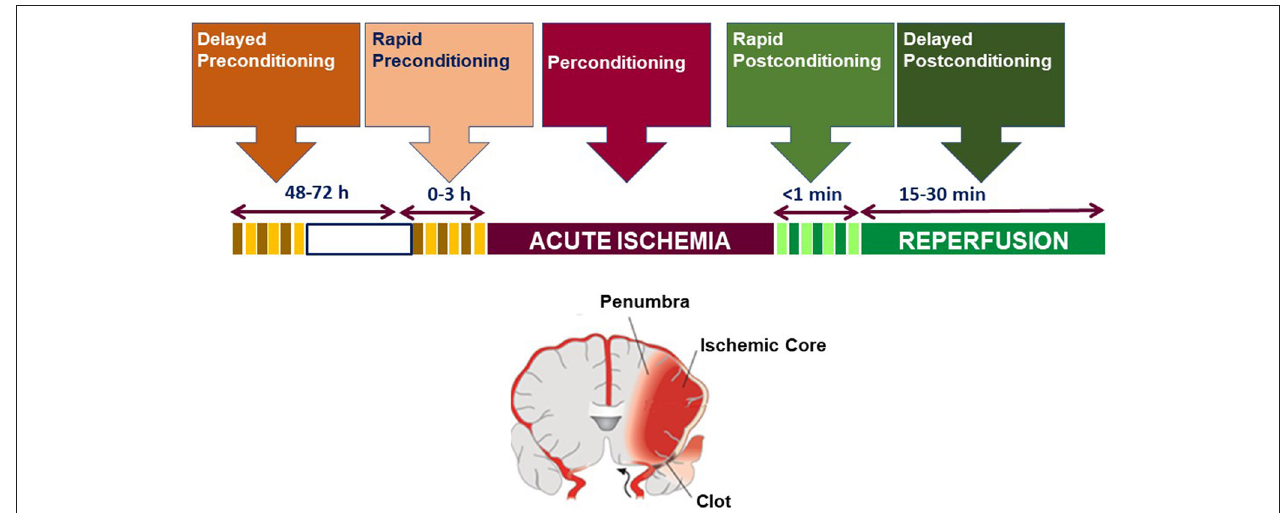
FIGURE 1 | Temporal profile classification of brain